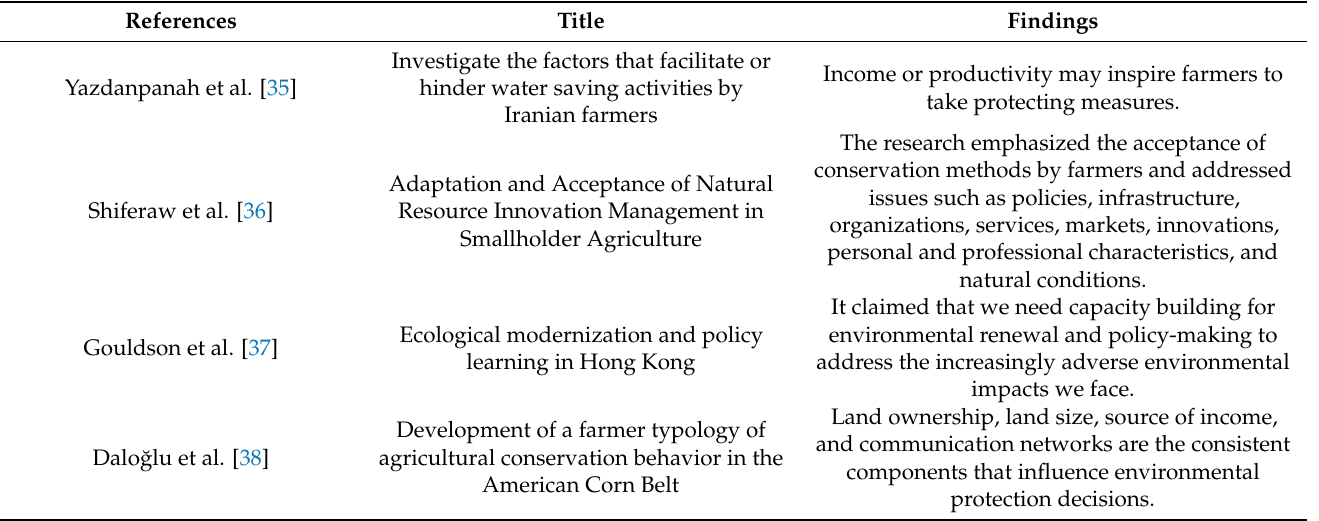
Table 1. A brief list of research on water conservation and their